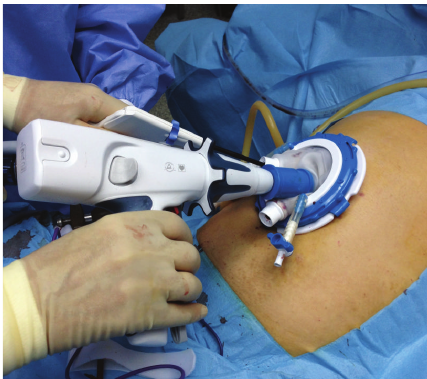
Figure4:Placementofthecircularstaplerthroughtheportandinto the jejunal